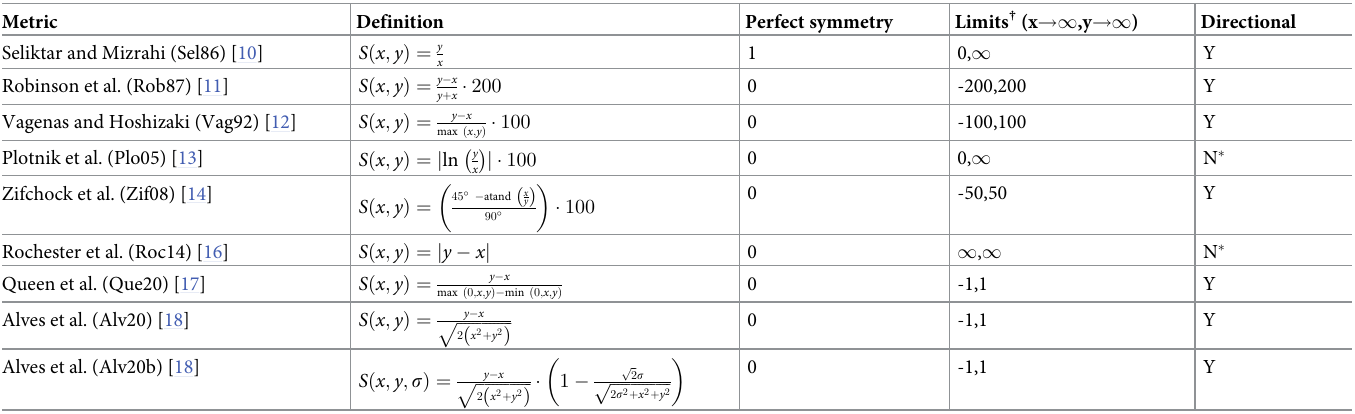
Table 1. Discrete symmetry